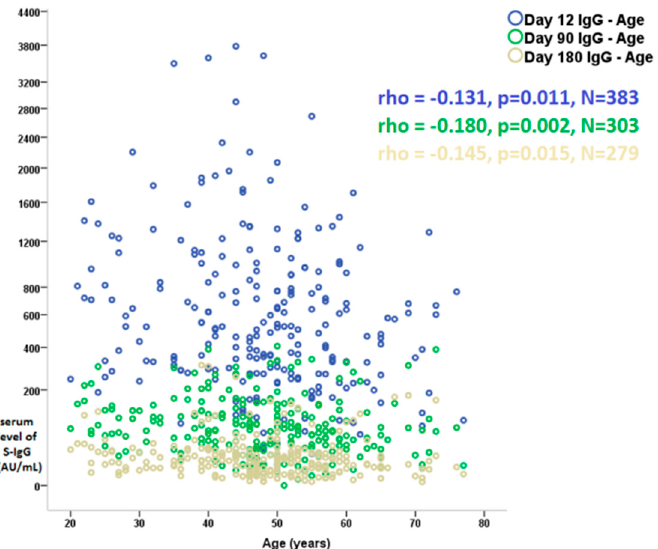
Figure 1. Correlation of serum level of S-IgG and age at Day 12, Day 90, and Day 180 follow-up visit after the 2nd dose of BNT162b2 mRNA (Pfizer/BioNTech, Comirnaty) vaccine. Values are Spearman correlation coefficients (rho). S-IgG; anti-spike immunoglobulin G, mRNA; messenger ribonucleic acid.